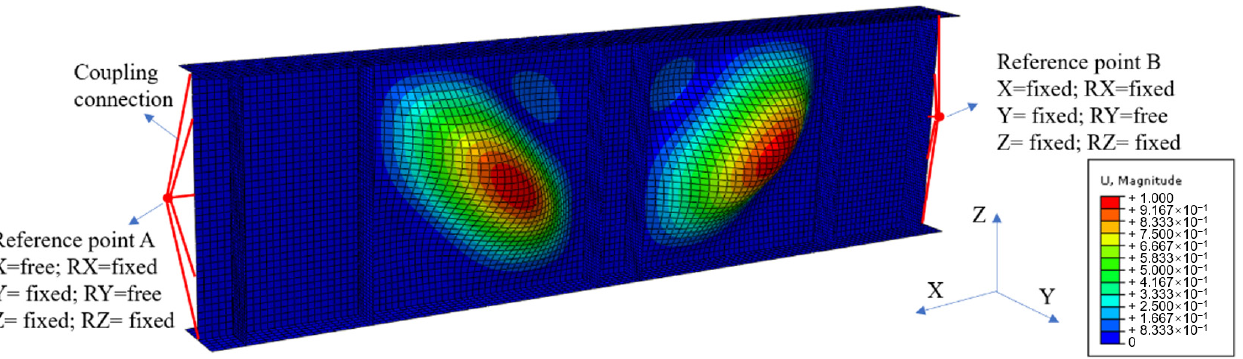
Figure 5. First buckling mode of the S600E s orbite SS plate girder.